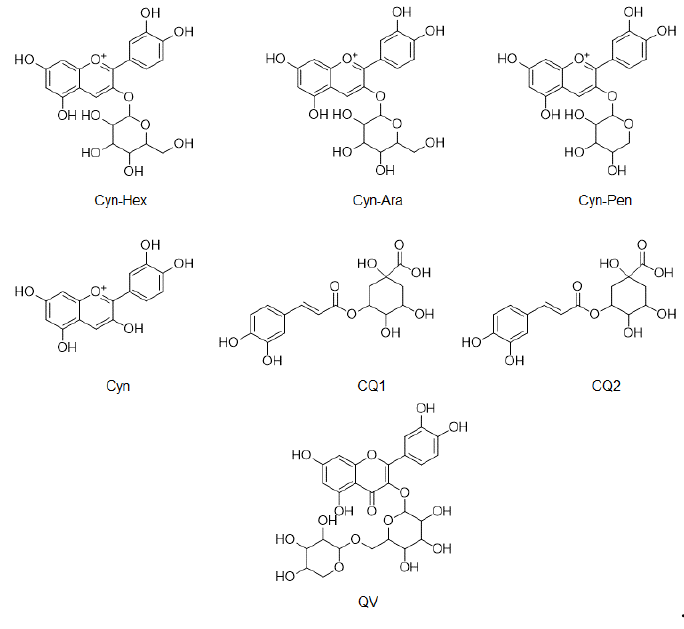
Figure 4. Chemical structures of compounds detected in LC/MS